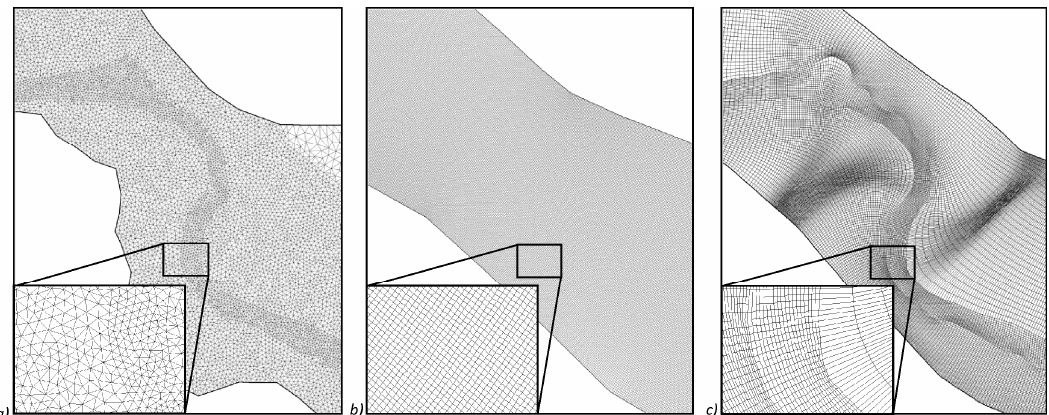
Figure 5. Different two-dimensional (2D) horizontal-plan schematizations. ( a ) Flexible mesh; ( b ) orthogonal grid; ( c ) curvilinear grid.